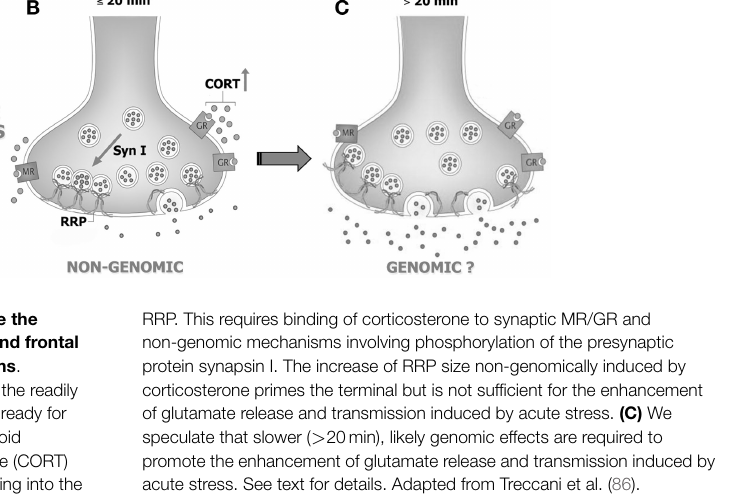
to 24 h after corticosterone application (88, 89). These